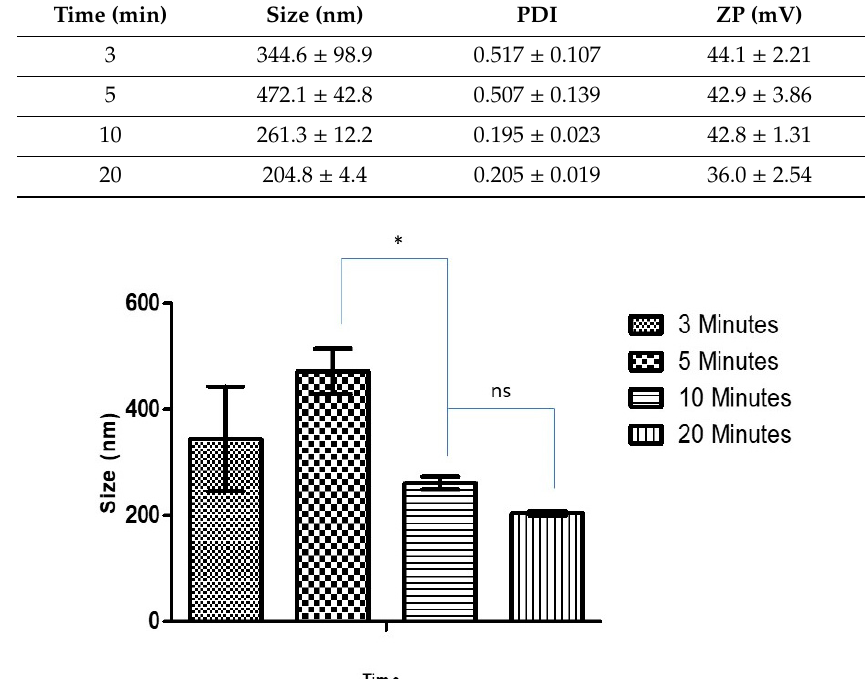
Table 2. Effects of sonication time on CSNPs loaded with 5 mg of Ag-FSE.